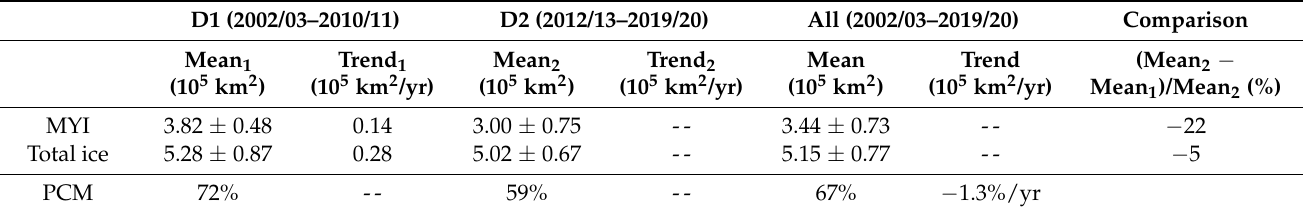
Figure 2. Sea ice area exports through the FS in winter seasons. The area export variability in MYI (total sea ice) is marked by red (green) lines. Gray bars show the PCM. MYI observations cover October 2002 to April 2020 except for the wintertime of 2011/2012 because of the gap in the operational periods between AMSR-E and AMSR2. The uncertainties of area flux are marked on red line. Table 1. The mean (M) and trend (T) in ice exports corresponding to Figure